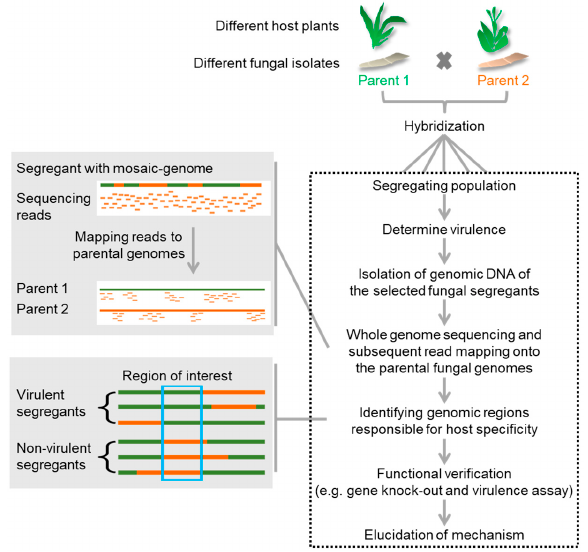
Figure 3. Strategy for identification of host-specificity factors using segregating populations of a hybridization event between two host-specific individuals. Virulence capacity of each offspring on one or both hosts is individually determined. Genome sequencing of fully virulent and avirulent offspring reveals parental origin of the mosaic genomes. Associating the parental origin of specific genomic loci to the virulence phenotype should lead to identification of genomic regions linked to host-specific virulence.